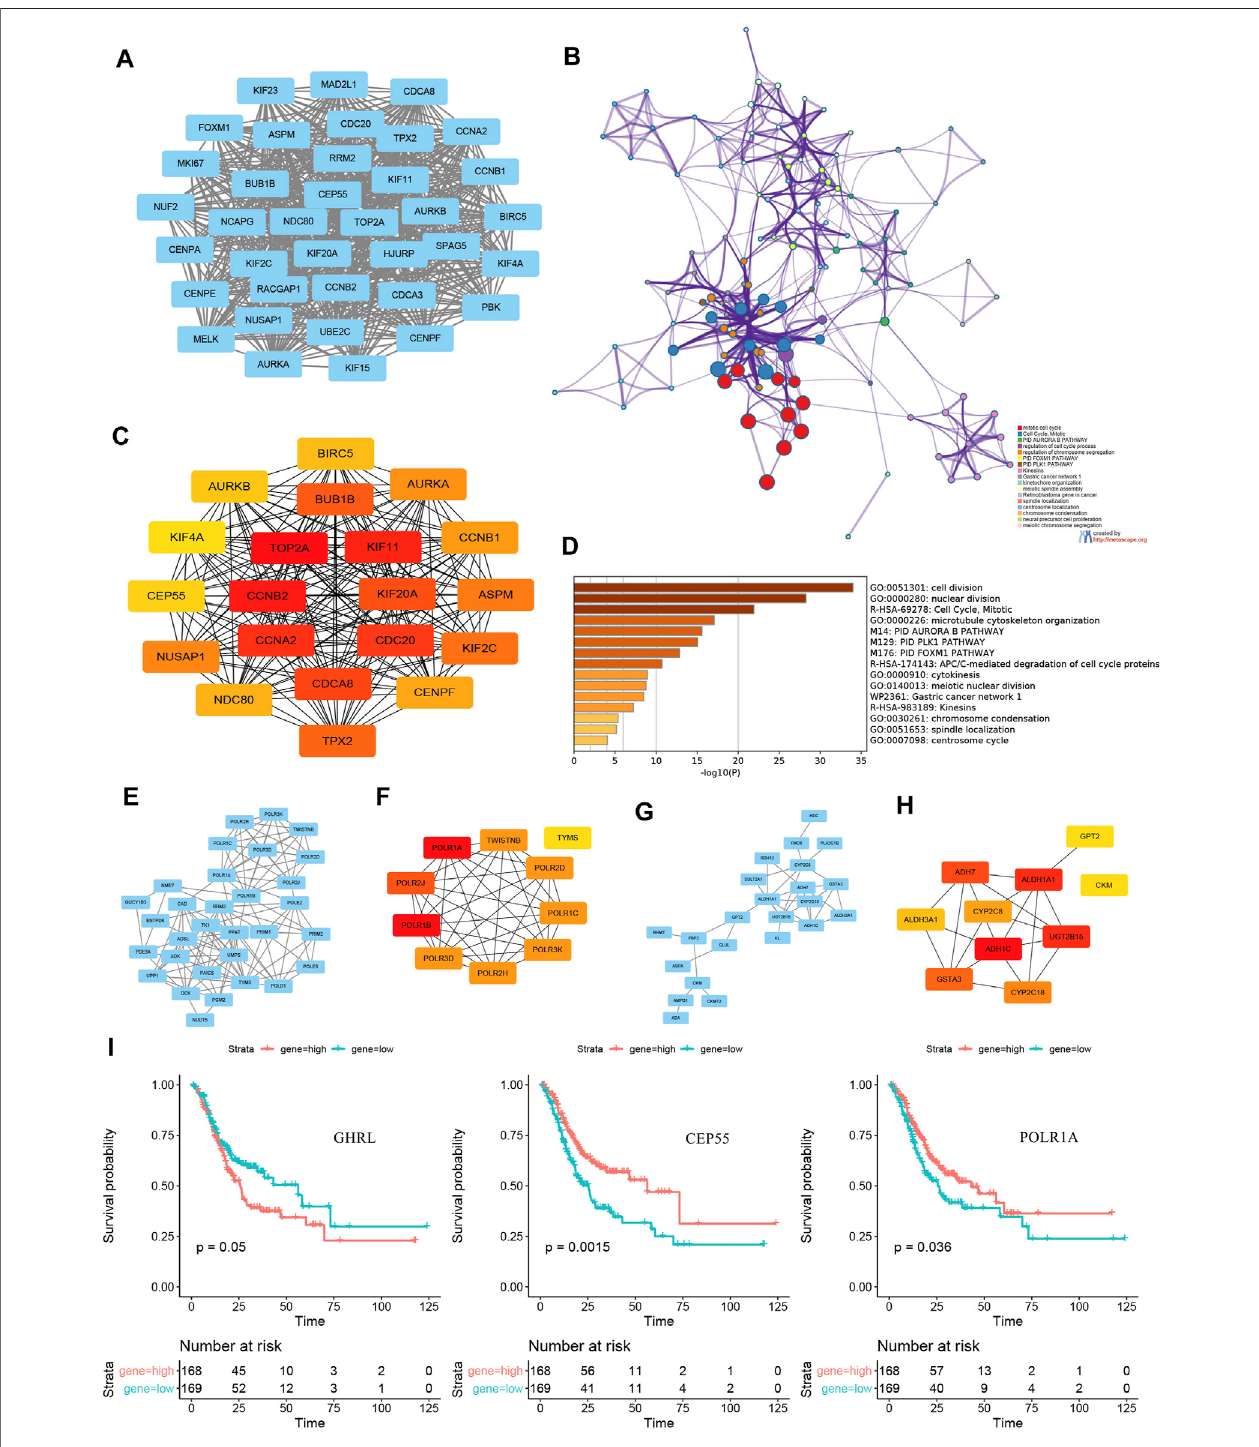
FIGURE5| PPIsubnetwork construction and hub genesidenti fi cation. (A) the fi rstsubnetwork ofPPIusing MCODE plug-in ofCytoscape. (B) enrichmentanalysis and visualization of fi rst cluster using Metascape online tool. (C) top 20 hub genes of all common DEGs identi fi ed by an MCC algorithm. (D) enrichment analysis and visualization of top 20 hub genes using the Metascape online tool. PPI networks and relevant hub genes of (E – F) 31 upregulated metabolic DEGs and (G – H) 30 downregulated metabolic DEGs. (I) survival curves of GHRL, CEP55, and POLR1A expression. PPI, protein – protein interaction; DEGs, differentially expressed genes; MCC, Multiscale Curvature Classi fi cation.